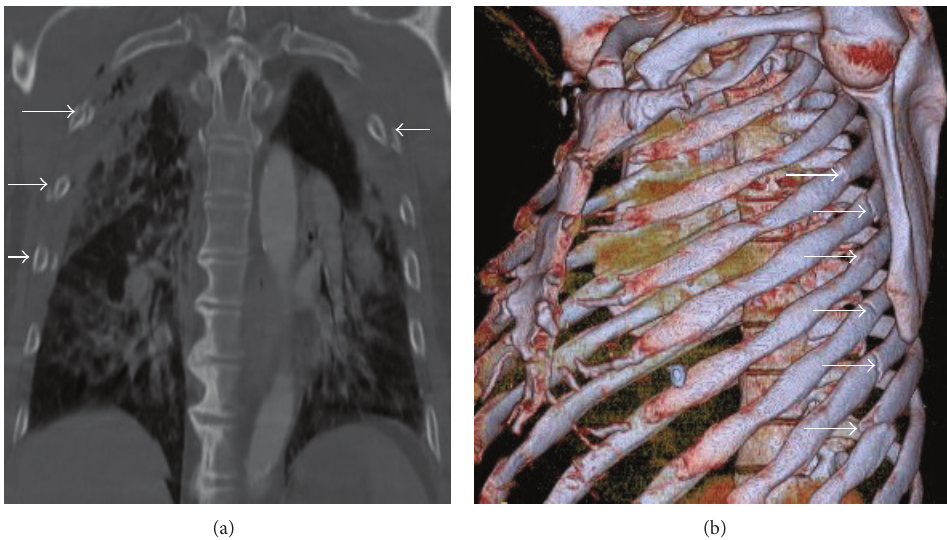
Figure 13: Rib fractures in 2 polytraumatized patients. Coronal MDCT in bone window (a) in a case of “flail chest” with four displaced rib fractures (straight arrows) in three consecutive right costal arches and in one left costal arc. Note the associated pulmonary contusions. Another patient (b) presenting with multiple left rib fractures (arrows), shown with oblique sagittal volume-rendering